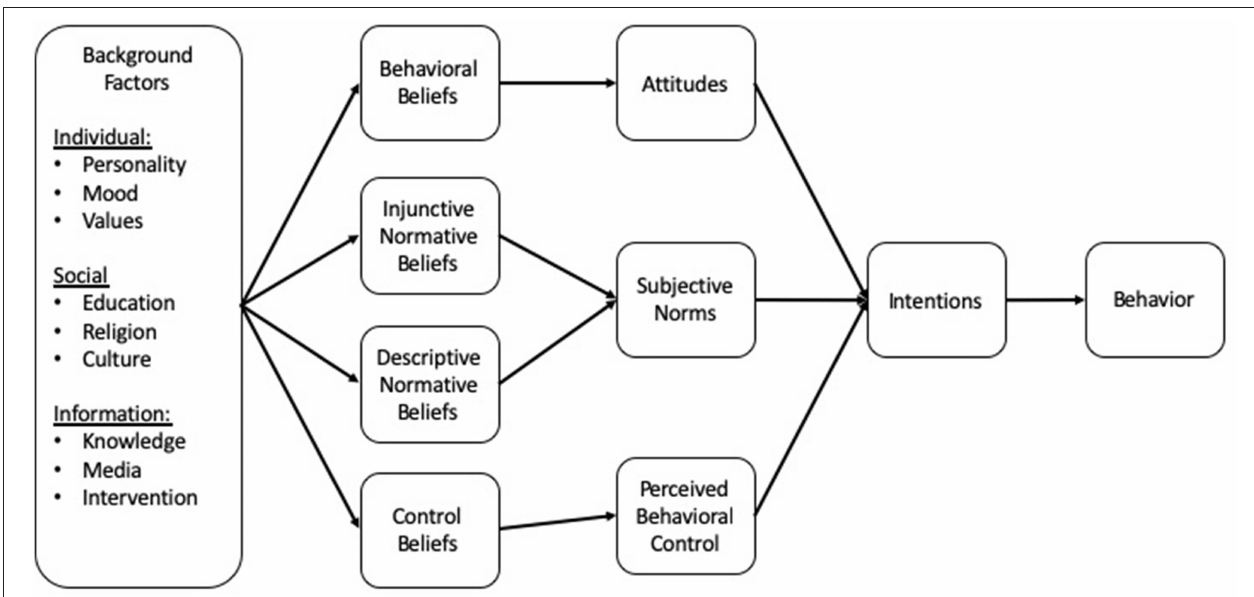
FIGURE 1 | A visual depiction of the Reasoned Action Model (Adapted From Fishbein and Ajzen, 2010).